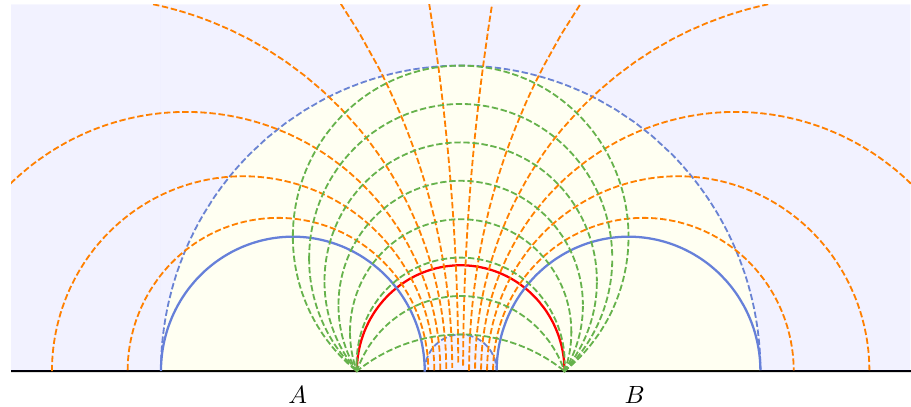
A graphic illustration of the construction of a maximally packed (cid:13)ow for two disjoint intervals in AdS. The two intervals are of equal size and are close enough so that the entanglement wedge r ( AB ) (shaded in yellow) is connected. The auxiliary minimal surface m ( ~ A ) is shown in red, and is picked such that it intersects orthogonally both m ( A ) and m ( B ), represented in blue. The set integral curves of the auxiliary vector (cid:12)eld ~ V are shown as orange dashed lines. These integral curves interpolate smoothly between m ( A ) ( m ( B )) and (cid:6) AB so they provide a natural family of nested intervals. The level set surfaces of ~ V are represented by green dashed lines. They correspond to the integral curves of the maximally packed (cid:13)ow V that computes entanglement of puri(cid:12)cation E ( A : B